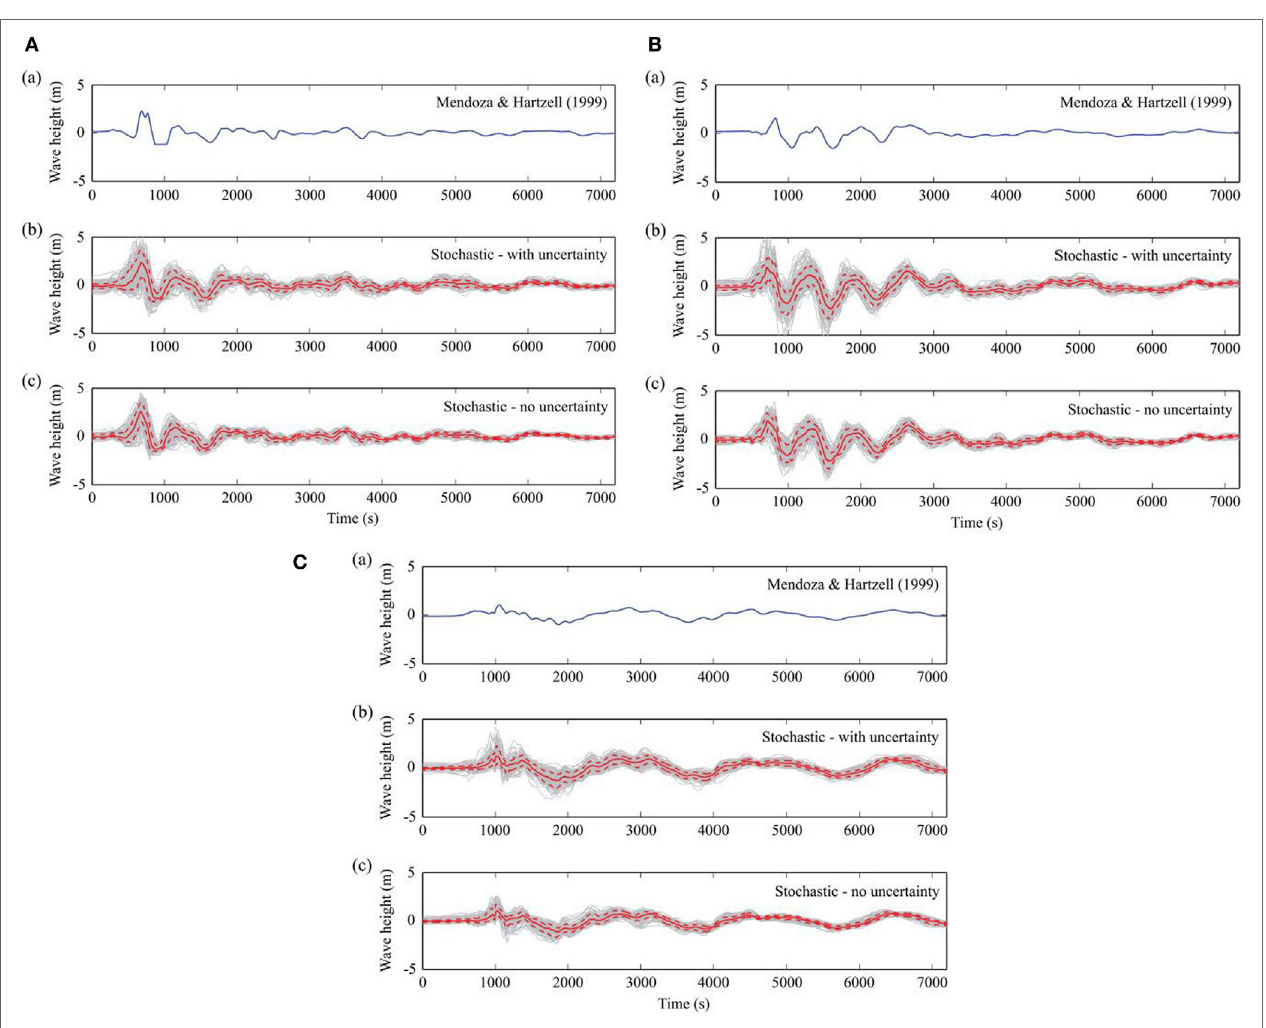
FigUre 13 | Tsunami waveforms at the recording locations: top to bottom: location 1–3. (a) Mendoza–Hartzell model, (B) stochastic models by considering prediction errors of the scaling relationships, and (c) stochastic models without considering prediction errors of the scaling relationships (solid line: mean, dashed line: upper and lower 16%, gray line: individual